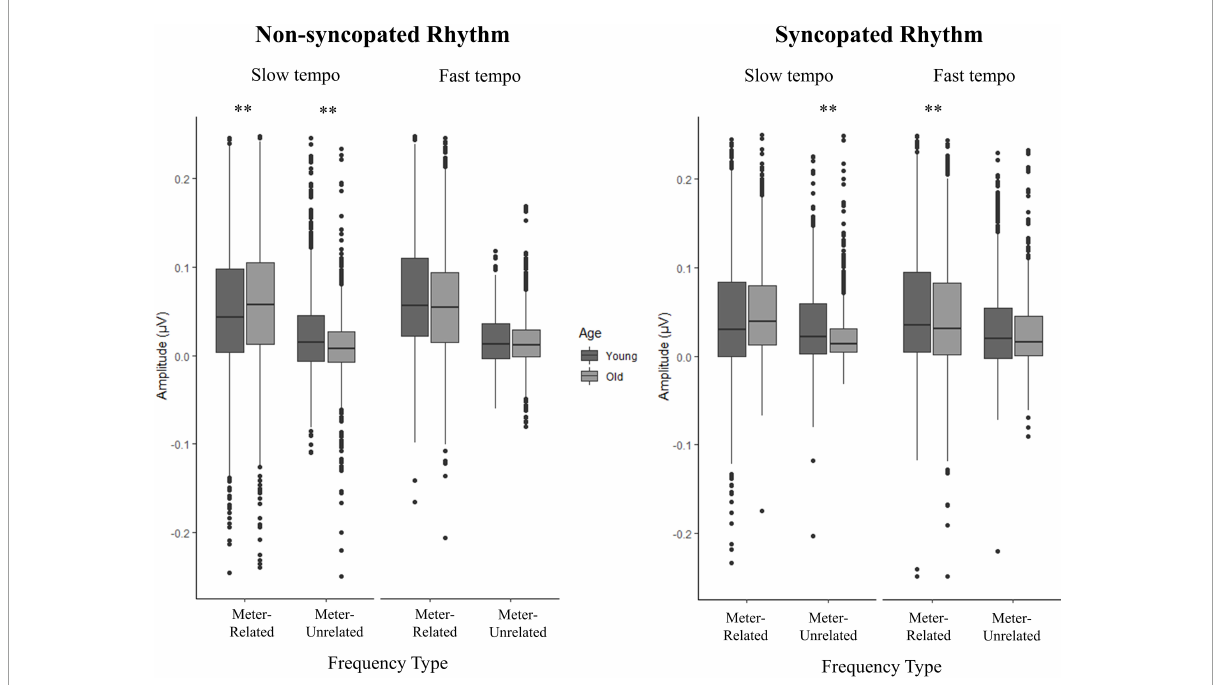
FIGURE7 Amplitude of neural activity at meter-related and meter-unrelated frequencies across the four conditions and groups. Boxes represent the first quartile, median and third quartile of data, vertical lines the maximum and minimum values as defined by third and first quartile ± 1.5 times the interquartile-range (third quartile - first quartile), with points representing outliers; data represents amplitude values for each frequency (4 m-related and 8 m-unrelated frequencies), channel (12 channels) and participant, totaling approximately 720 and 1440 data points for meter-related and meter-unrelated frequency types, respectively. ** p < 0.006 (Bonferroni